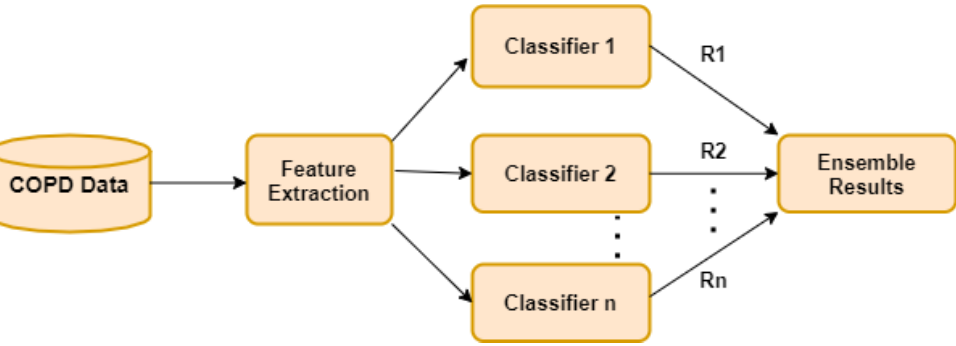
Figure 1. The basic architecture of SVE classifier for COPD classification. Table 3. Severity detection: classifiers and specifications.